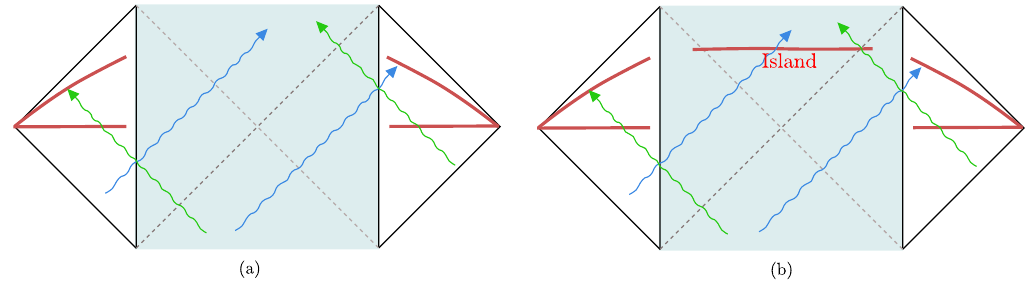
Figure 4 . (a) Growing entropy for the radiation for an eternal black hole plus radiation in the thermo(cid:12)eld double state. We draw two instants in time. The particles with the same color are entangled. They do not contribute to the entanglement of the radiation region (indicated in red) at t = 0 but they do contribute at a later value of t . (b) When the island is included the entanglement ceases to grow, because now both entangled modes mentioned above are included in I [ R